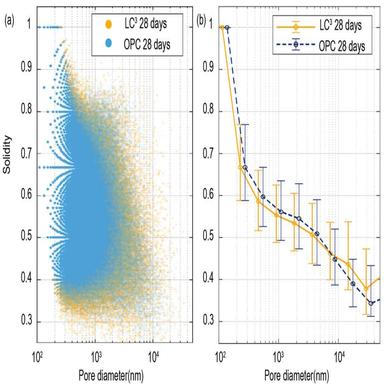
Shape descriptor, solidity, of LC3 and OPC. (a) Scatter diagram of 28-day LC3 and OPC and (b) statistic curve of the average solidity distribution.